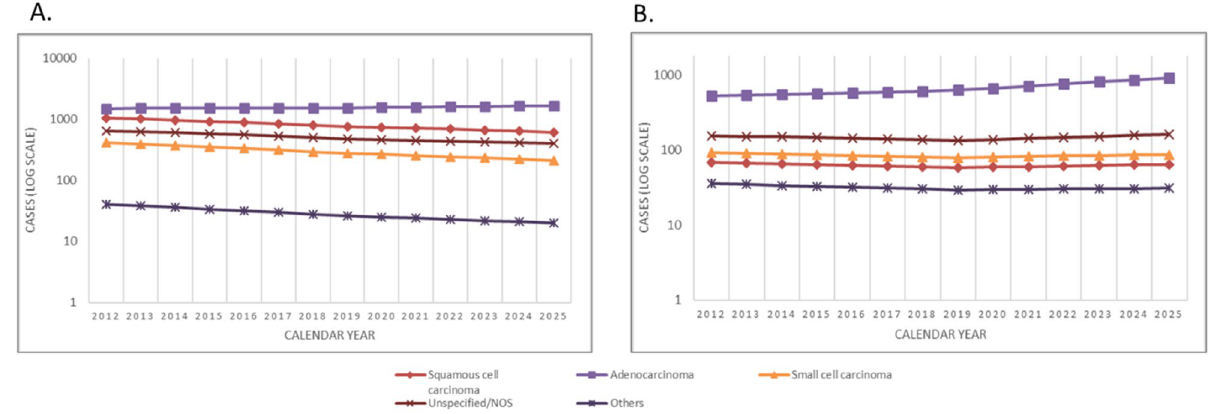
Figure 1. Incidence of lung cancer in men ( A ) and women ( B ) in Catalonia between 2012 and 2025 by histology. NOS: not otherwise specified. Others: This group contains several histological types of low frequency. Note: These figures reflect trends in the number of new lung cancer cases per year.